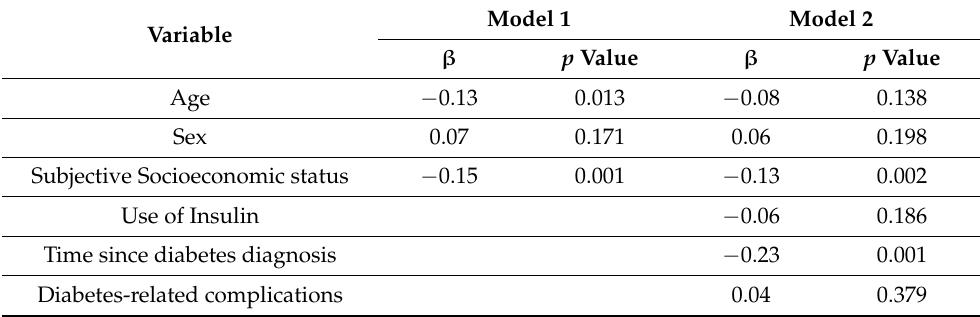
Table 4. Regression analysis for the relationship between stigma surrounding diabetes, sociodemo- graphic, and clinical